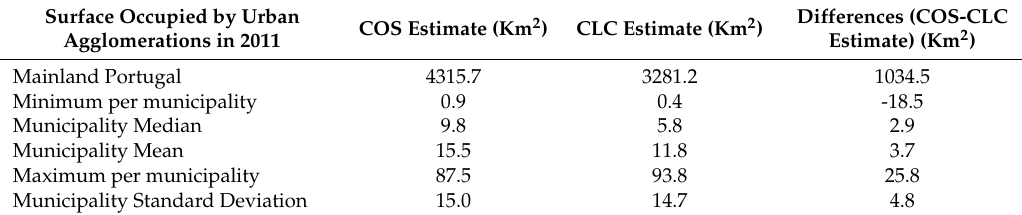
Table 2. Descriptive statistics on the surface occupied by urban agglomerations estimated by COS and by CLC for